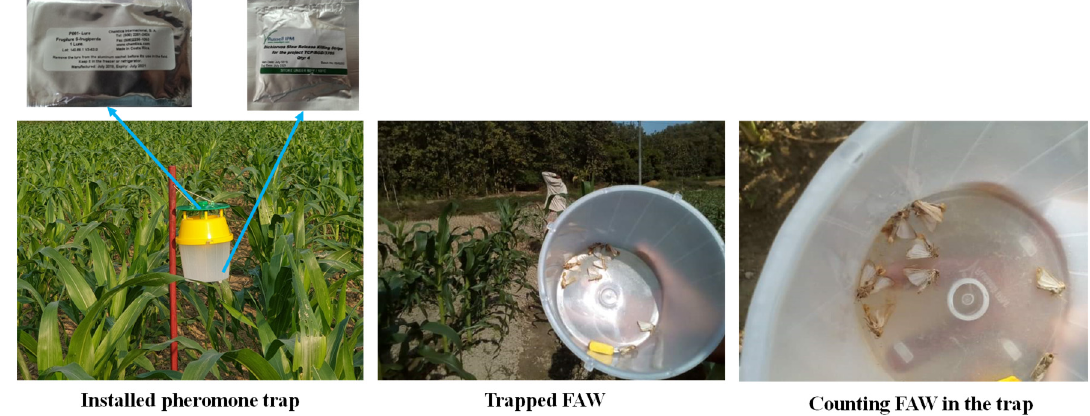
Figure 5. Pheromone traps for monitoring fall armyworm in a maize field.